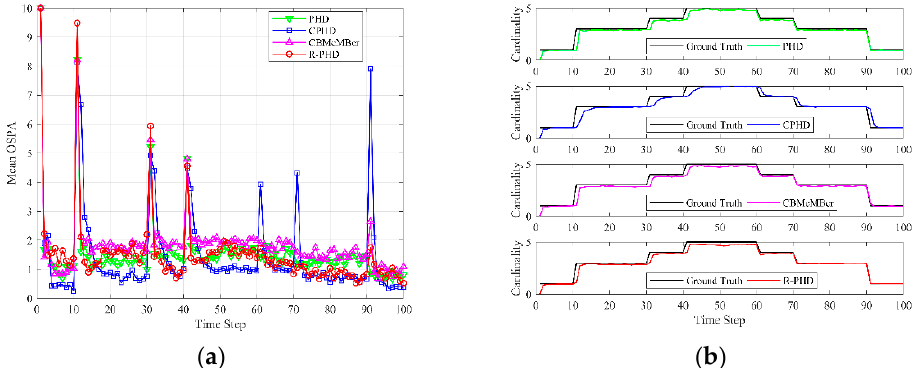
Figure 5. OSPA and cardinality performances of different methods versus time ( p D = 0.95, λ = 20): ( a ) mean OSPA; ( b ) mean cardinality.